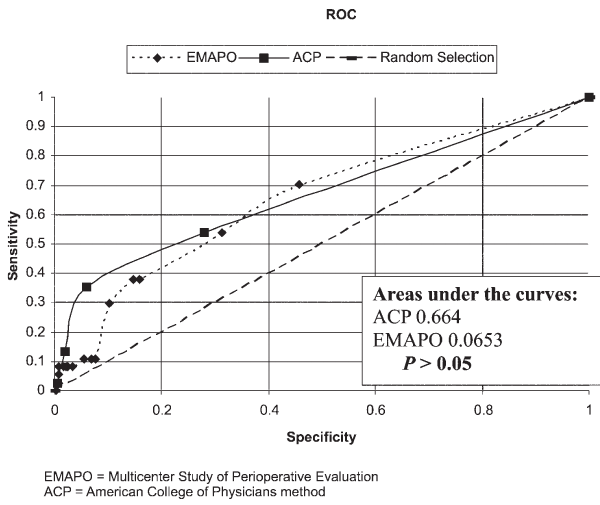
Figure 2 - ROC (receiver operating characteristic) curves according to the results from EMAPO and ACP